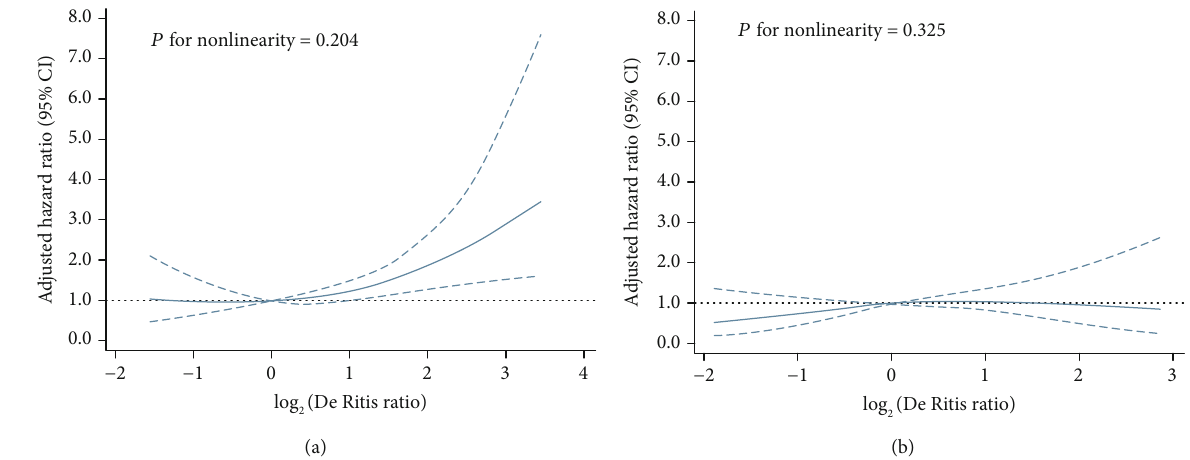
Figure 5: Cubic spline plots of the association between the log -transformed De Ritis ratio and the risk of mortality among adult onset MHLH 2 (a) and non-MHLH (b). Analyses were adjusted for hepatomegaly, albumin (ALB), fi brinogen (FIB), EBV, ferritin, malignancy-associated HLH (MHLH), and treatment strategies. Table 3: Strati fi ed associations between De Ritis ratio and overall